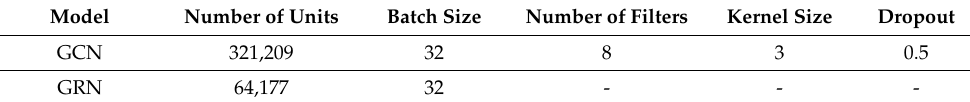
Table 4. The parameters of the training model GCN and GRN.